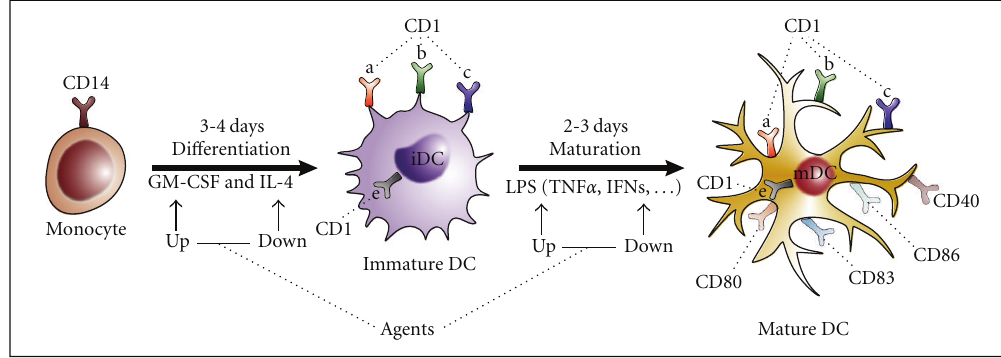
Figure 1: Dendritic Cell (DC) generation and maturation. Schematic drawing depicting the di ff erentiation of monocytes to immature DC (iDC), generation of mature DC (mDC) and cytokines involved in these processes. Dotted lines point to the modulating e ff ects of external